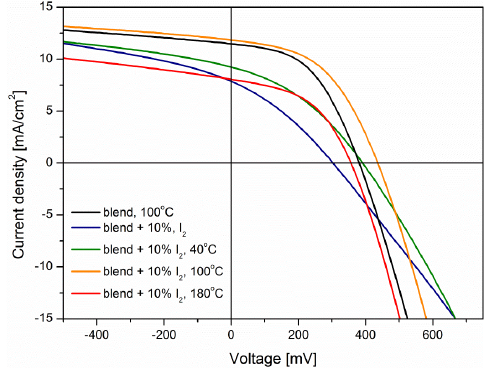
Figure 13. Current density-voltage characteristics of studied devices.